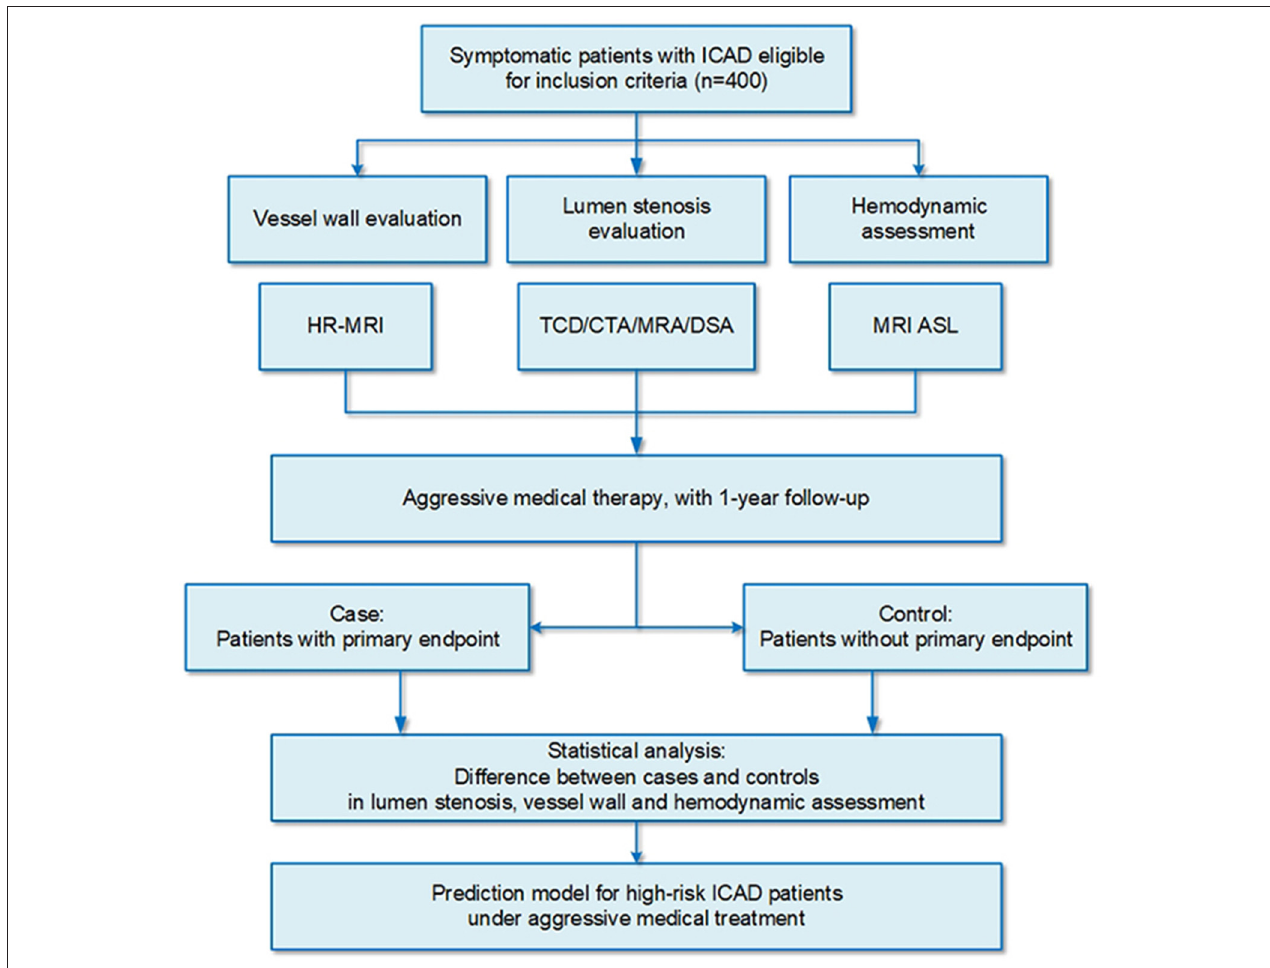
FIGURE 1 | Schematic representation of the